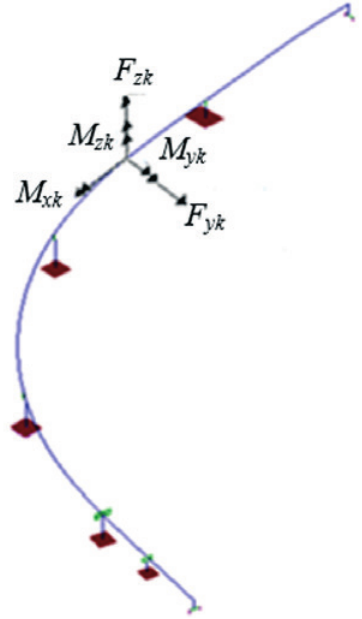
Figure 7 ‘Unifilar’ model of the curved bridge with an example of the applied forces at the